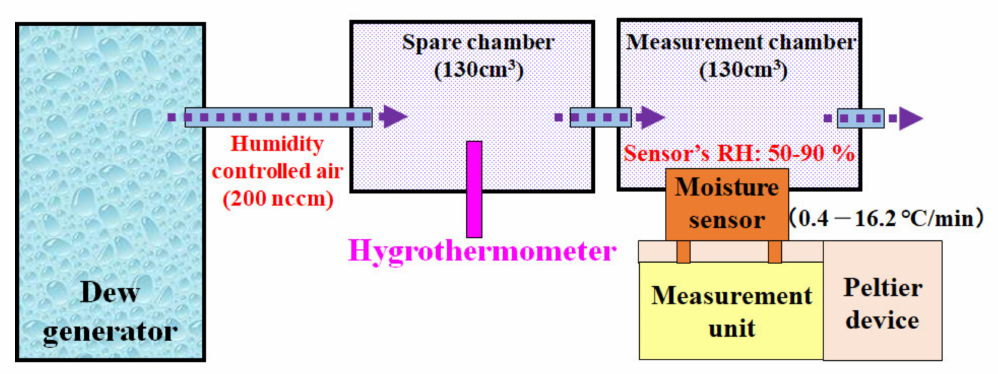
Figure 2. Schematic diagram showing the experimental setup for the introduction / adsorption of water droplets onto a moisture sensor by introducing humidity-controlled air while measuring the current.